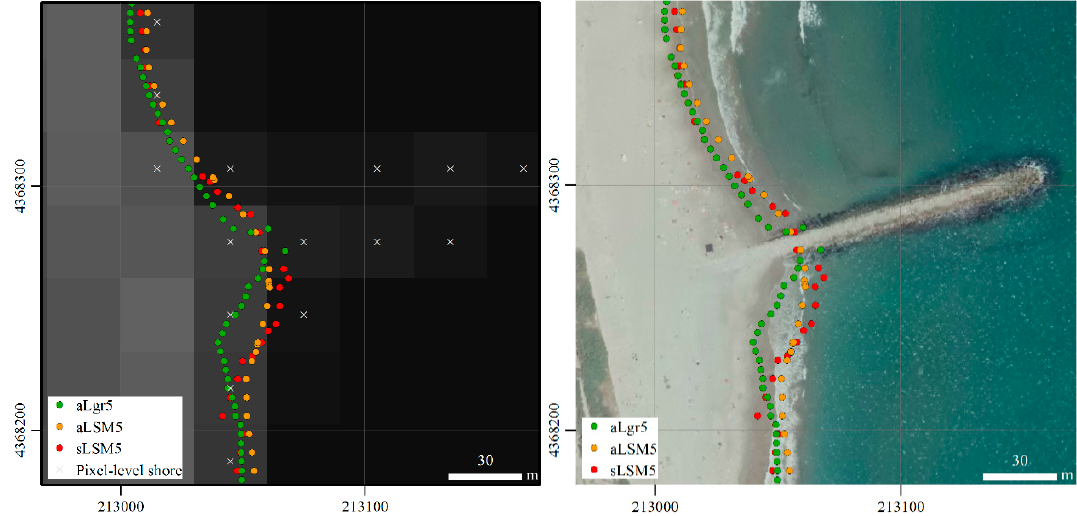
Figure 14. Map of a groin area with different sub-pixel shoreline solutions obtained for 2 June 2016 displayed on its corresponding L8 image on the left, and on a generic orthophoto (2015 PNOA sources) on the right. The grid coordinates are GCS_ETRS89 UTM31N.